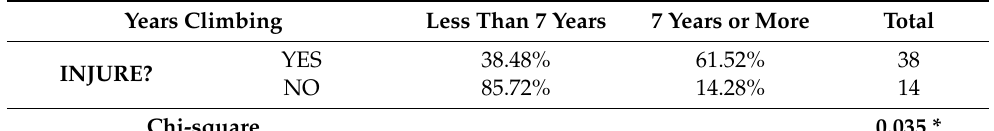
Table 3. Contingency table and Chi-square test for the association between the presence of injury and years practicing climbing. Years Climbing Less Than 7 Years 7 Years or More Total YES 38.48% 61.52% 38 INJURE? NO 85.72% 14.28% 14 Chi-square 0.035